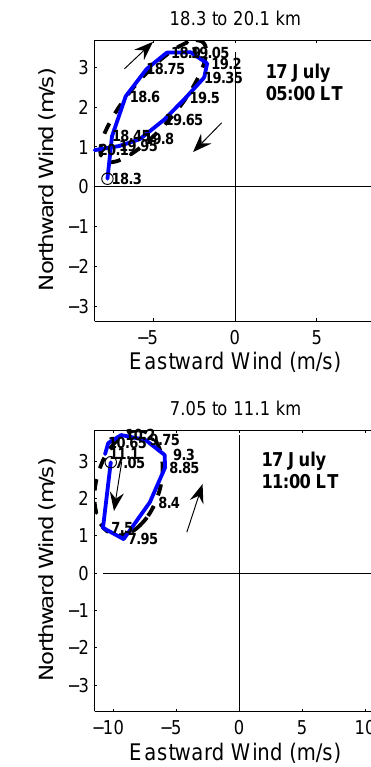
Fig. 8. Hodographs of the horizontal wind fluctuations in stratosphere and troposphere. The lowest height is marked by solid circle and the direction of rotation is indicated by